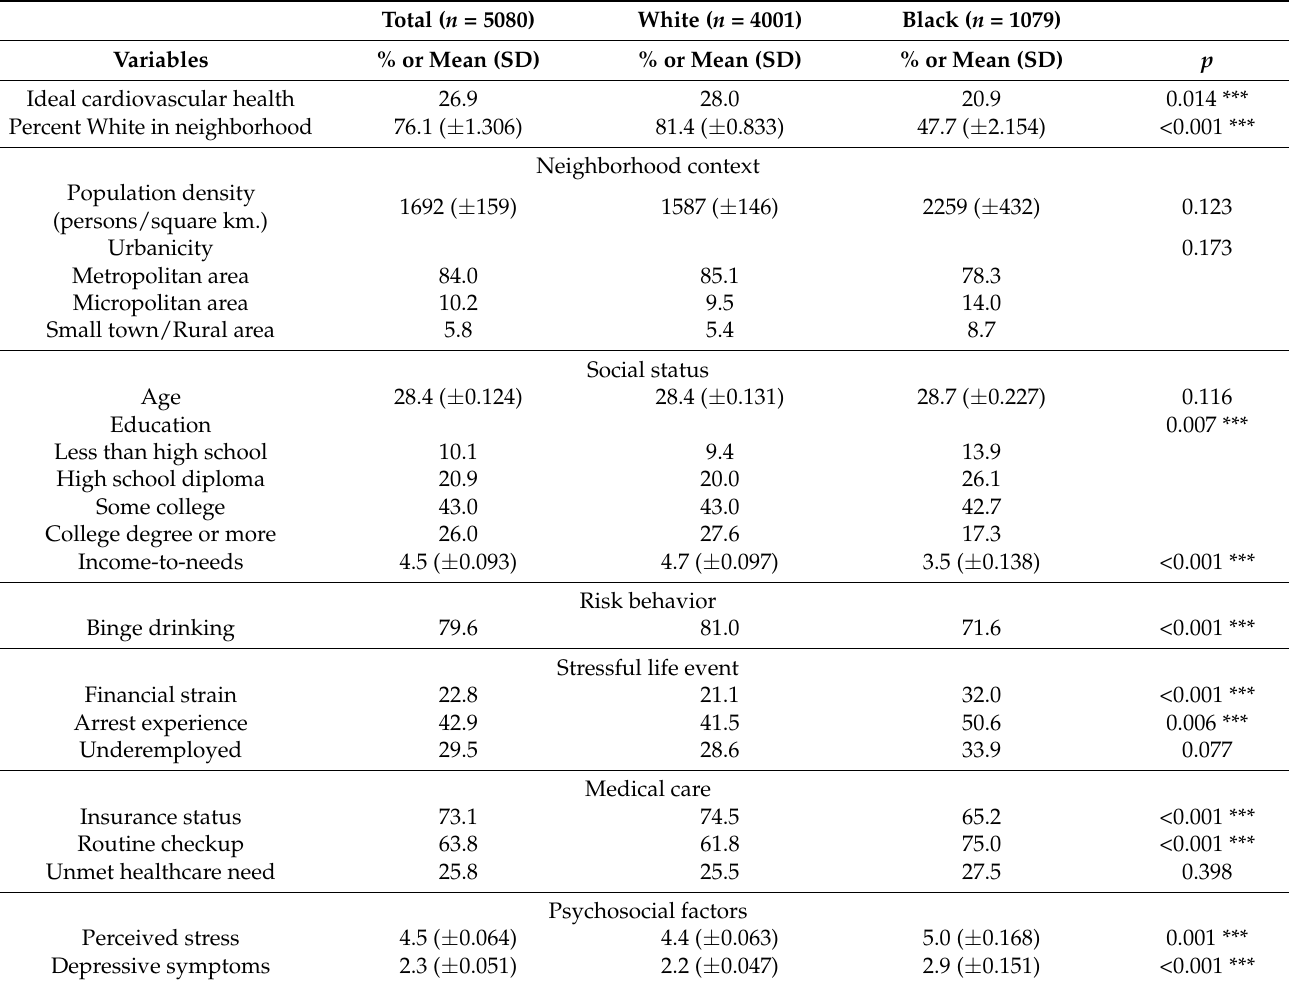
Table 2 presents analyses on the odds of having ideal CVH to test proposed hypotheses on race differences in ideal CVH and the role of RRS among young men. Hypothesis 1. White men will be more likely to have ideal CVH than Black men.